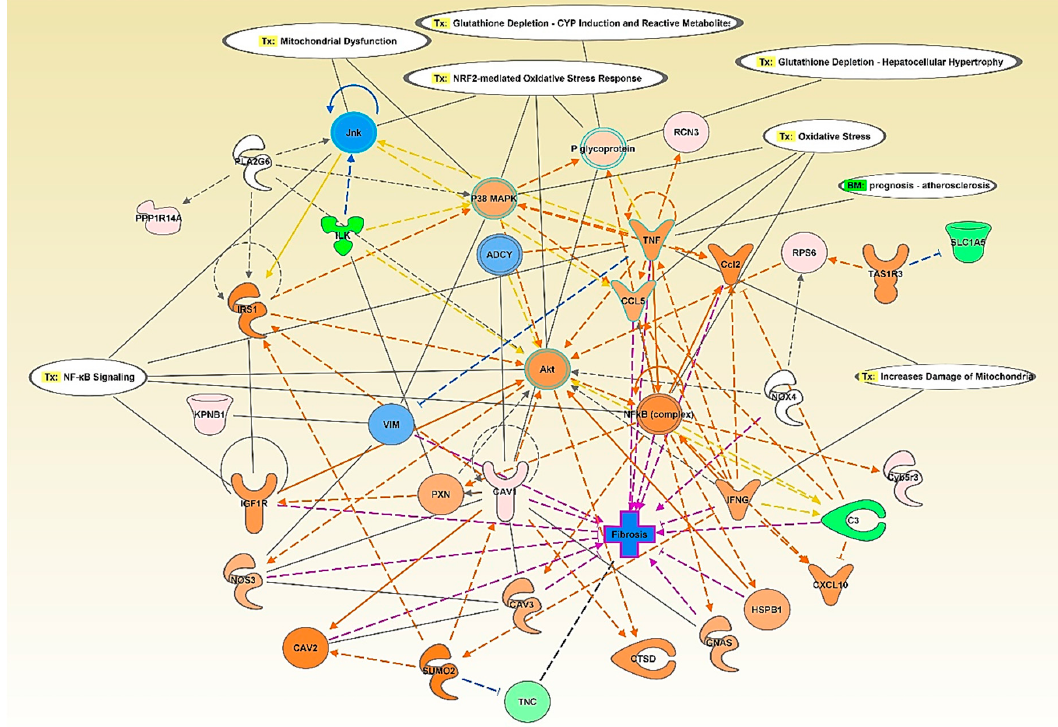
Figure 3. Ingenuity pathway analysis (IPA) network analysis of the modified proteins in response to BK 48 h stimulation relative to control in RASMC. The top toxicity (Tox) functions linked to the altered proteins are oxidative stress, mitochondrial dysfunction, increased damage of mitochondria, NRF2 mediated stress response, and glutathione depletion. Red indicates an upregulated protein, green indicates a down-regulated protein, orange indicates an activated protein, and blue indicates an inhibited protein. The color intensity represents the level of expression.